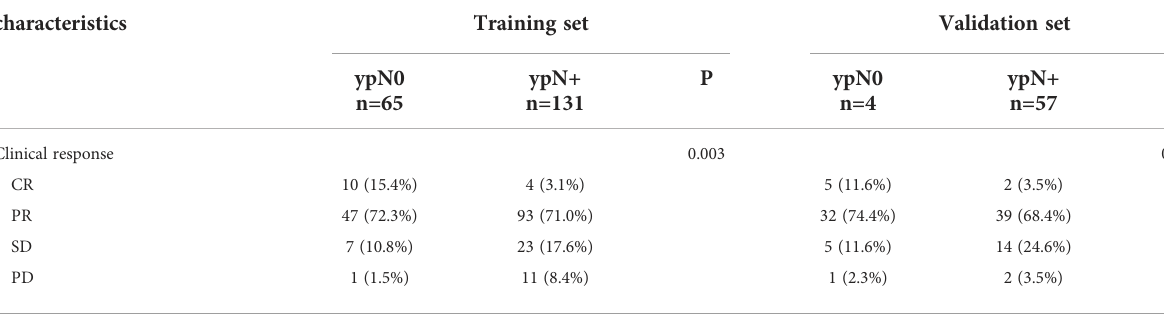
Figure 2E for the validation set with 1000 steps bootstrap resampling, illustrating good consistency between the predicted result and actual probability.